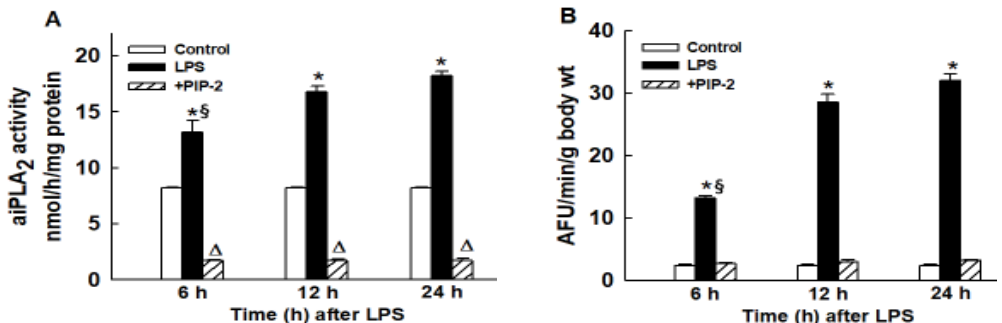
Figure 2. PIP-2 inhibits the increased lung aiPLA2 activity and increased ROS generation that follows LPS administration. LPS (5 µ g / g body weight) was administered by intratracheal (IT) instillation along with liposomes alone (labeled as LPS) or with PIP-2 in liposomes (labeled as + PIP-2). Control was liposomes alone without LPS (labeled as control). Mice were sacrificed at 6, 12, or 24 h after LPS and some lungs were perfused in situ for 15 min with saline solution ( A ) while others were perfused in situ for 15 min with saline solution containing the fluorophore difluorofluoroscein diacetate (DFF-DA) ( B ). Lungs were then homogenized and assayed for aiPLA 2 activity ( A ), or fluorescence of the lung homogenate as an index of ROS production ( B ). Results are mean ± SE for n = 3 for ( A ) and n = 4 for ( B ). * p < 0.05 vs. both the corresponding control and the corresponding LPS + PIP-2 values at the same time point; § p < 0.05 vs. 12 h and 24 h LPS values; ∆ p < 0.05 vs. corresponding control value.